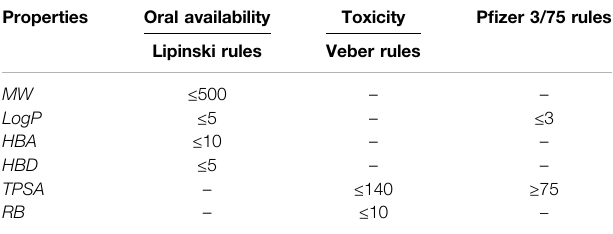
TABLE 1 | Empirical rules for predicting oral availability and toxicity of a